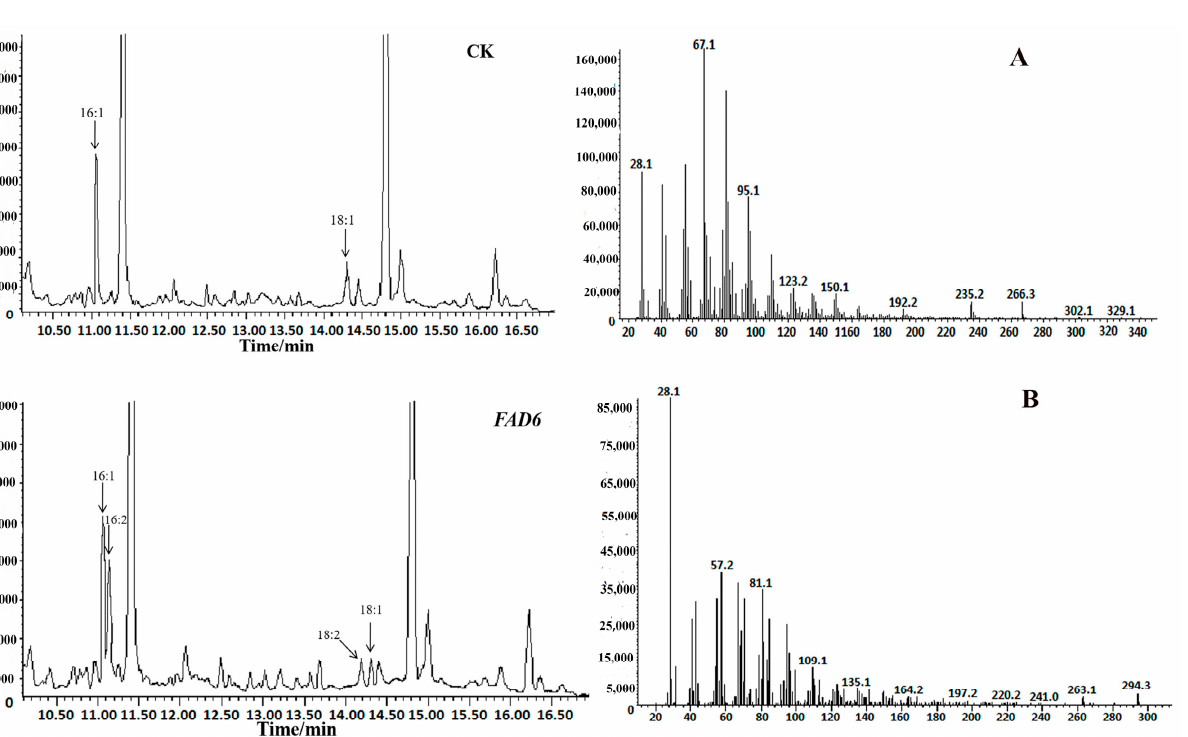
Figure 1. GC analysis of FAMEs from the cyanobacterium cells transformed with the plasmid psyn- CtFAD6 and empty vector (CK). Note: The ( A , B ) are the spectrum of peaks 16:2 and 18:2,